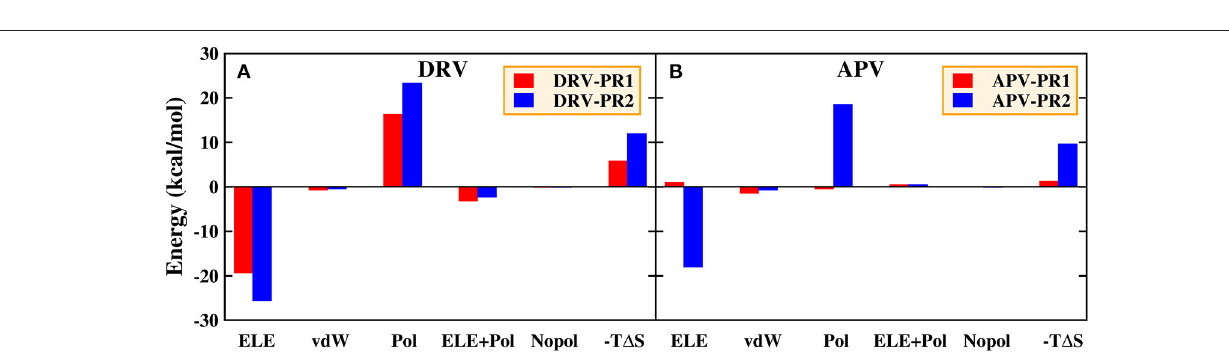
FIGURE 15 | Decomposition of the binding free energy on a per-basis into contributions from electrostatic interaction (ELE), van der Waals interaction (vdW), polar solvation energy (Pol), the sum of electrostatic interaction and polar solvation energy (ELE + Pol), non-polar solvation energy (Nopol), and entropy change (-T 1 S) in the Asp30 residues. (A) DRV complexes. (B) APV